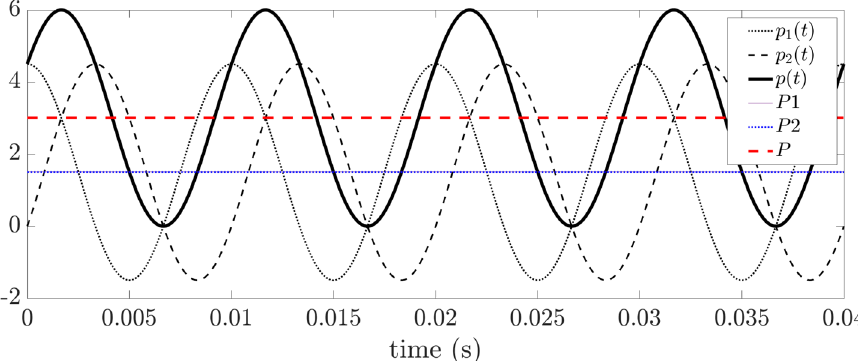
Figure 4. Power flow in channels α 1 and α 2 , total instantaneous power and active power for the circuit in Fig.